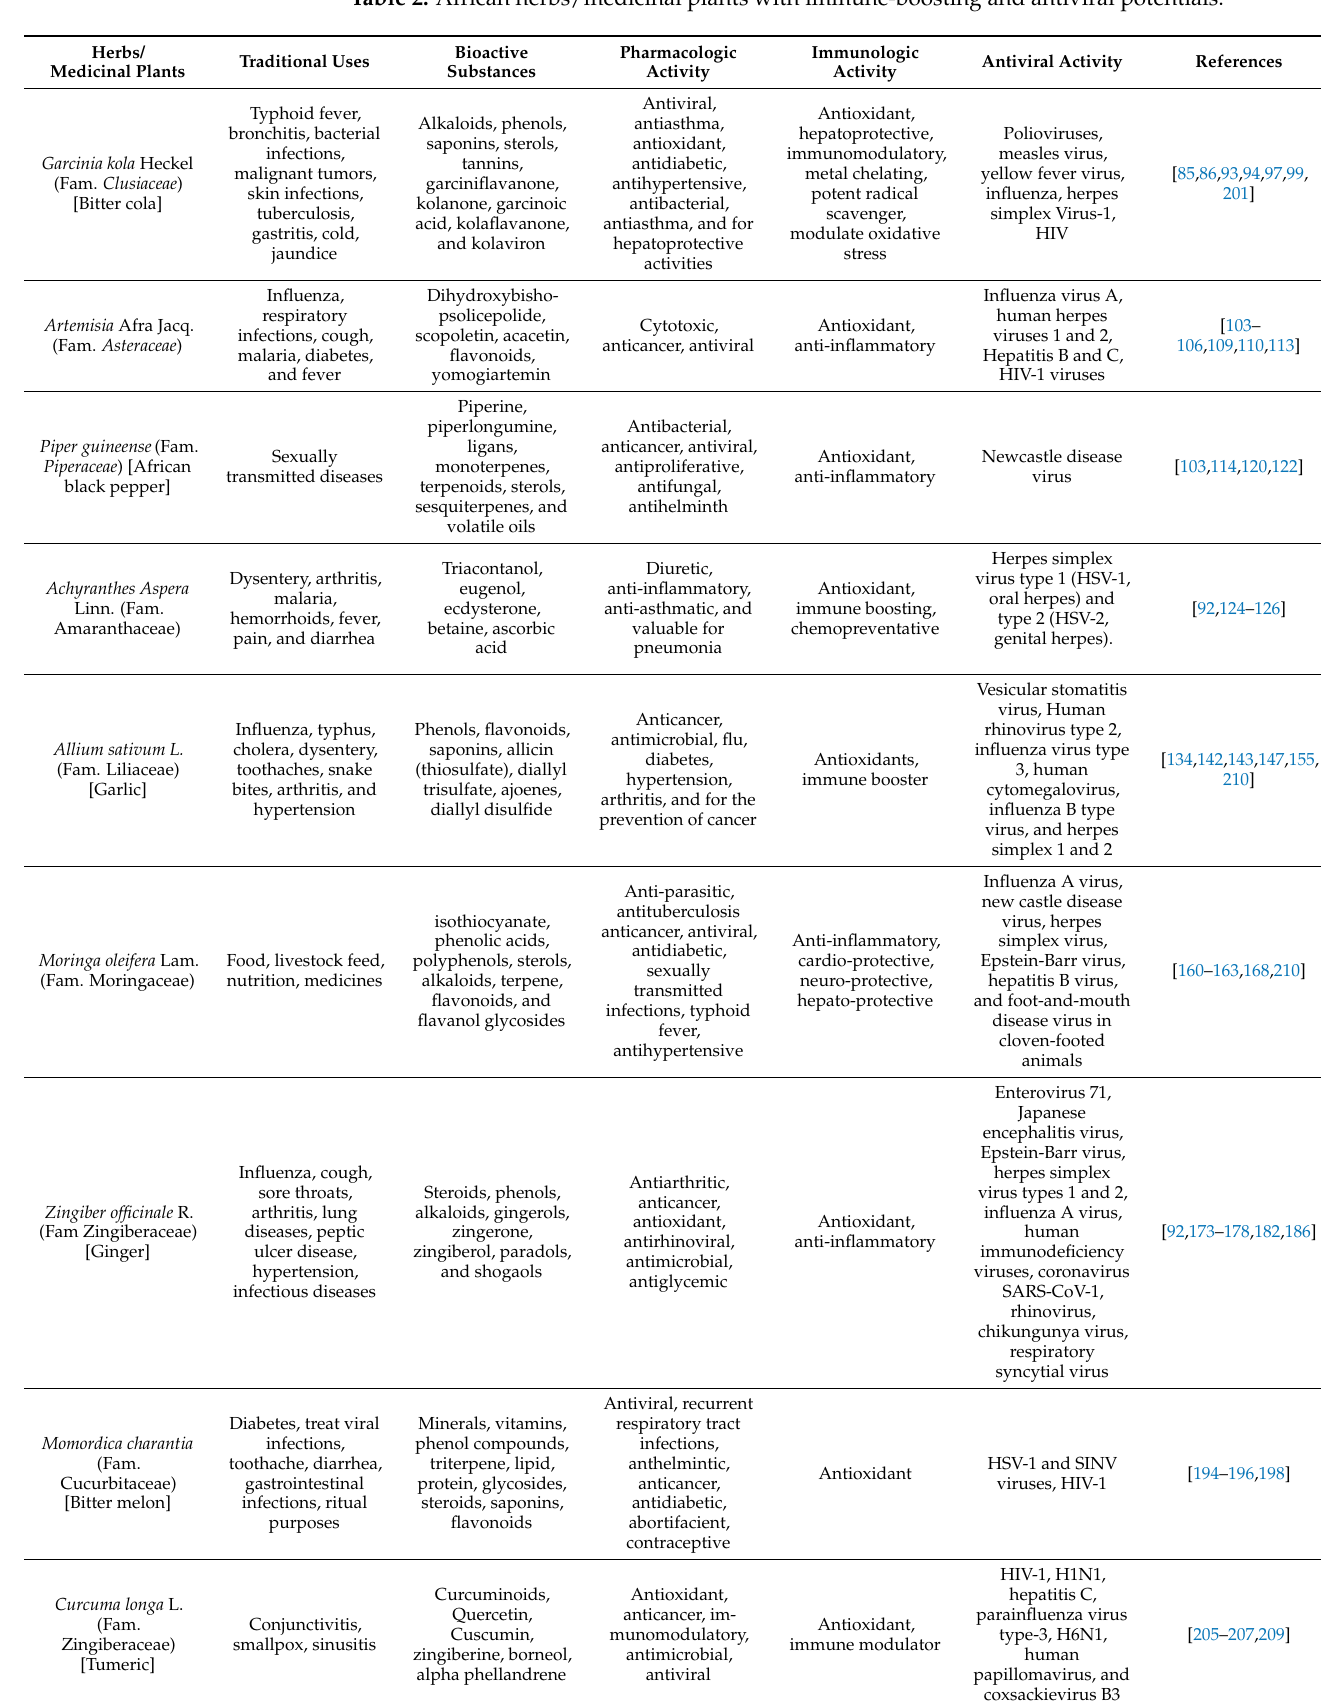
Table 2. African herbs/medicinal plants with immune-boosting and antiviral